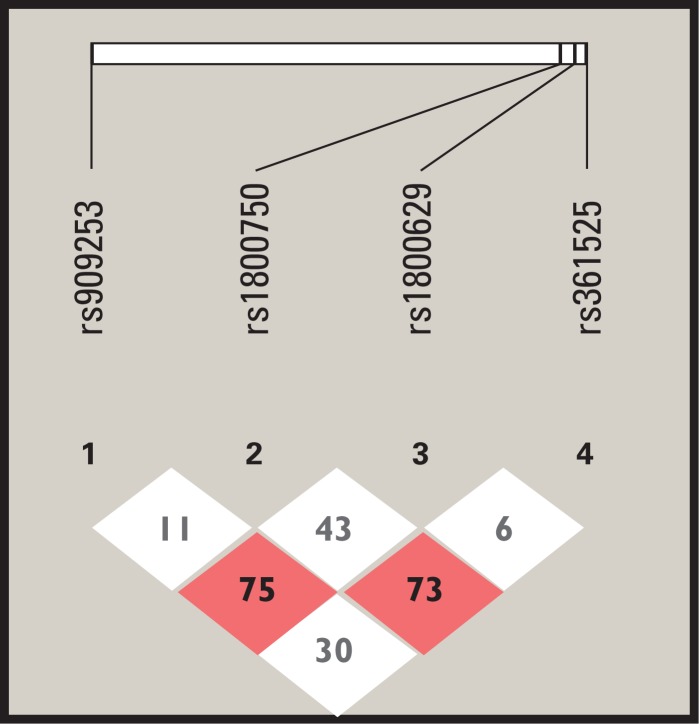
Haplotype for TNF gene at Chr 6 in ILI patients.Linkage disequilibrium between the four single nucleotide polymorphisms identified at chromosome 6 in the TNF gene (generated for the ILI patients in Haploview 4.2).